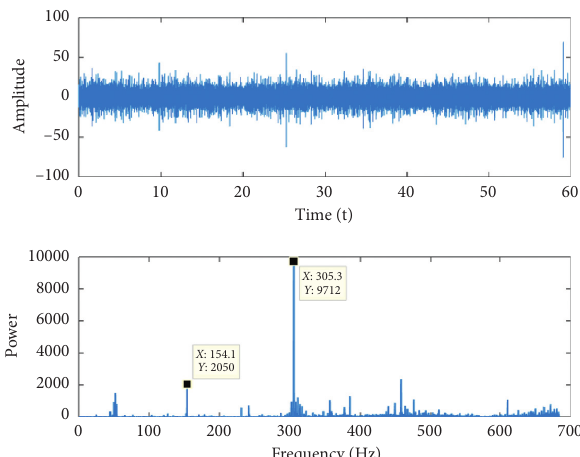
Figure 21: Time domain and frequency domain diagram for signal of compound fault